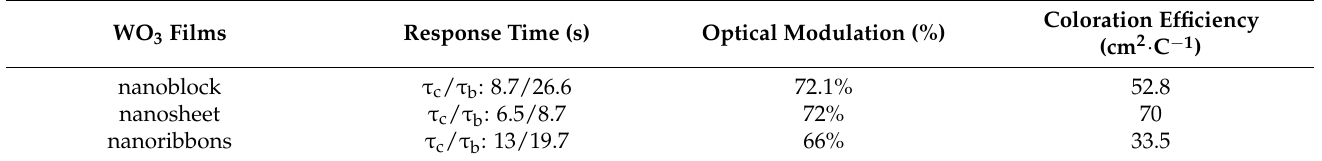
Table 1. Near-infrared electrochromic properties of the WO 3 films with different morphologies.